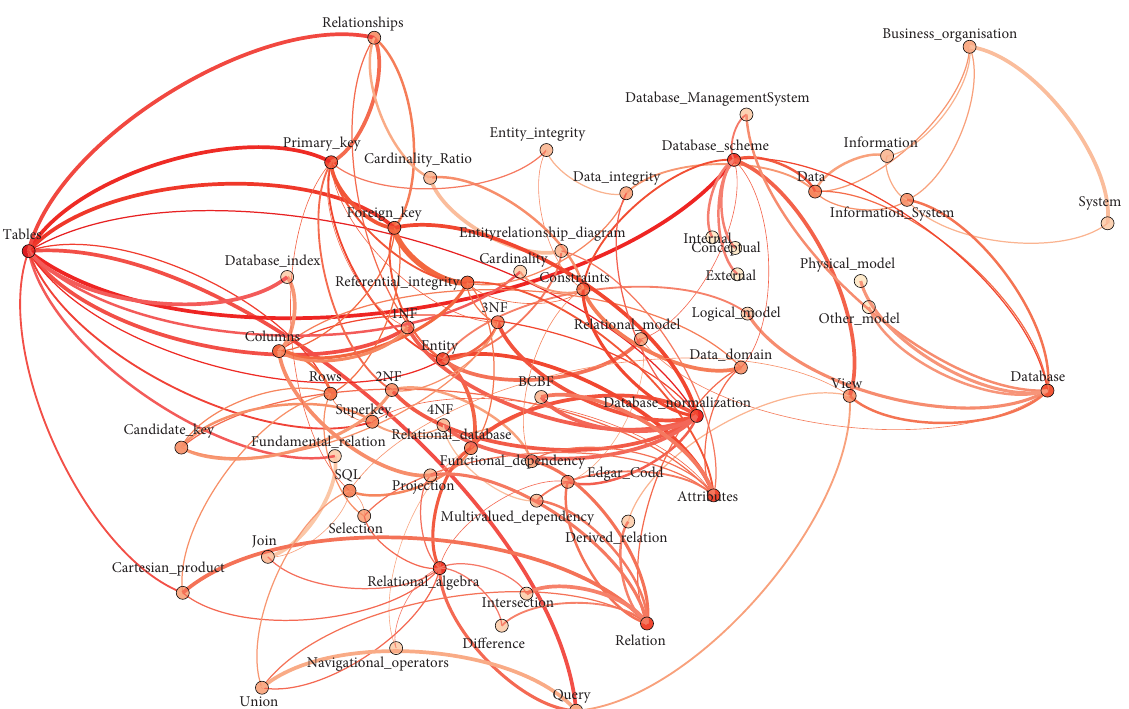
Figure 4: The visualization of the monolayer network according to the degree. Nodes with high degree values are darker, while nodes with lower degree values are lighter